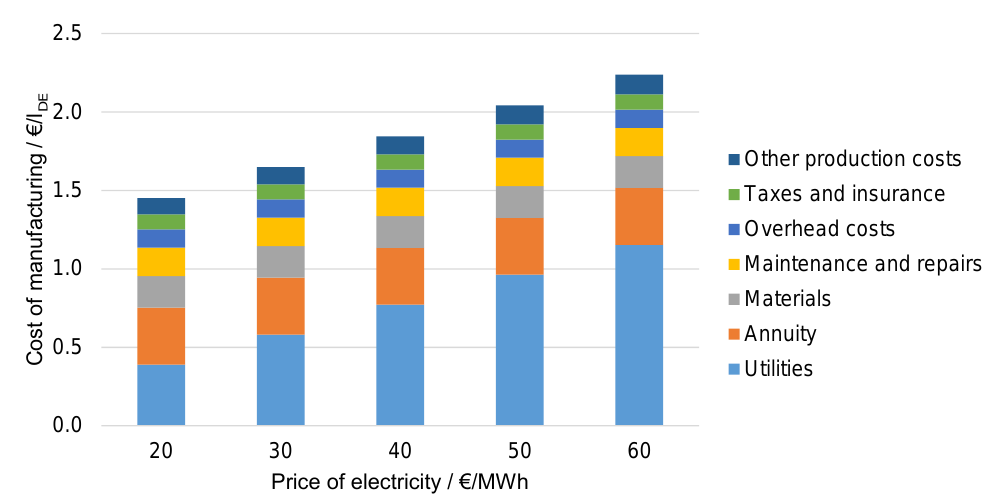
Figure 17shows the fuel production costs as a function of the electrolysis efficiency.